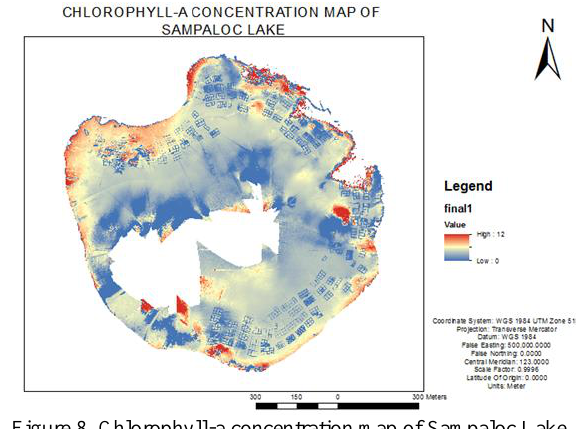
Figure 8. Chlorophyll-a concentration map of Sampaloc Lake